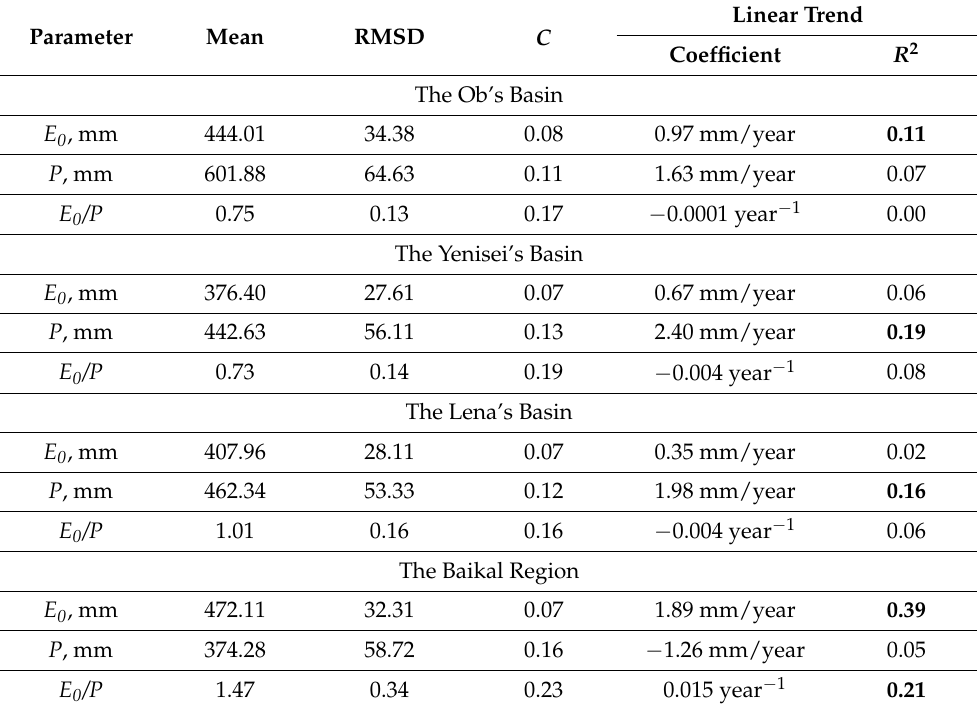
Table 2. Distribution of statistical parameters of potential evapotranspiration components for Siberian stations for 1981–2015. Bold values mean significant trends (by Student’s test at α = 0.05).